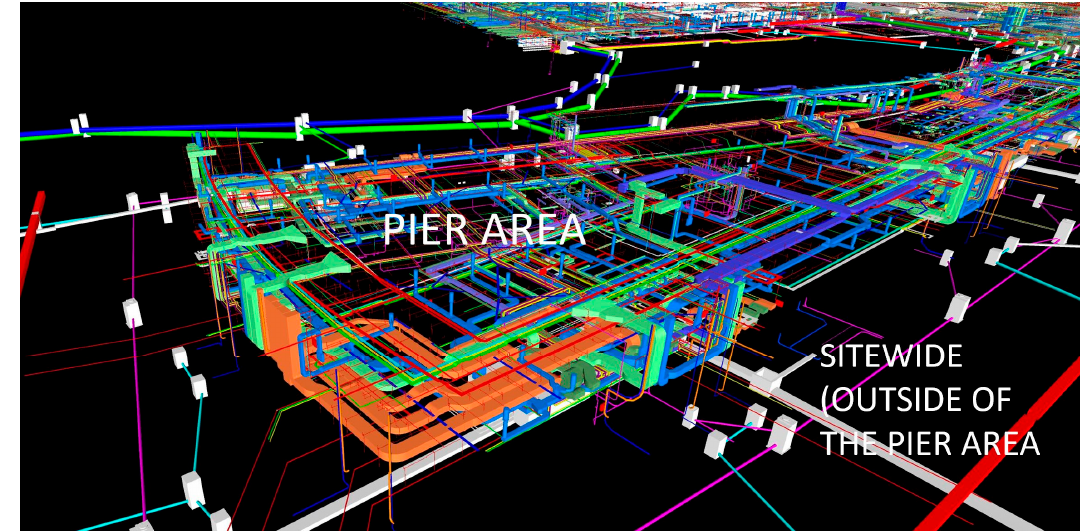
Figure 3. Viewpoint of the Merged MEP-Infrastructure INA BIM Model Focusing on a Pier Building Area. Blue & Green & Orange: HVAC Ducts, Purple: Waste water discharge line, Red pipes (inside the terminal area): Fire protection, Red (outside the terminal area): Underground network line composed of pipes, manholes, and slot drains, Red trays: Cable trays, Green & Dark Blue (outside the terminal area): Landside drainage, White: Electrical duct banks with manholes